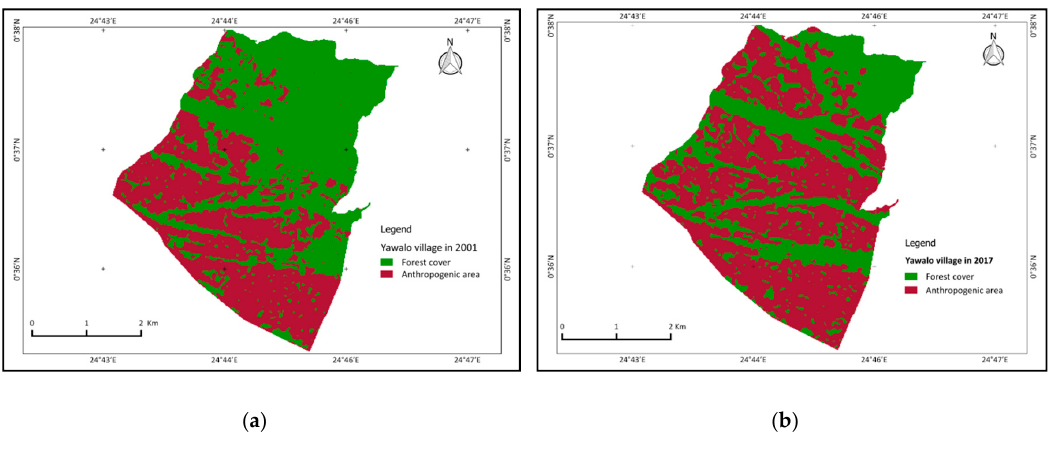
Figure 2. Change in forest cover in Yawalo village between 2001 ( a ) and 2017 ( b ). Table 1. Annual Changes in Yawalo’s Forest Cover